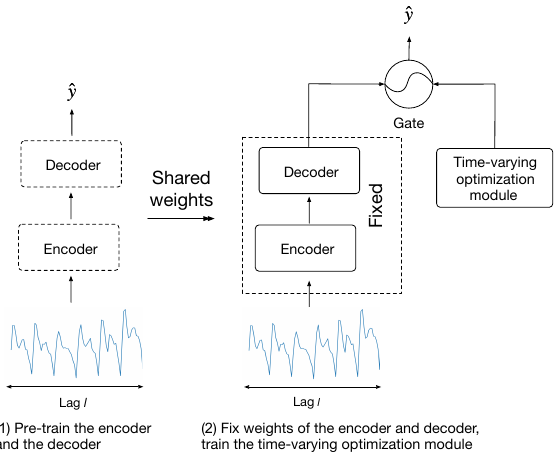
Fig. 5 Two-stage training